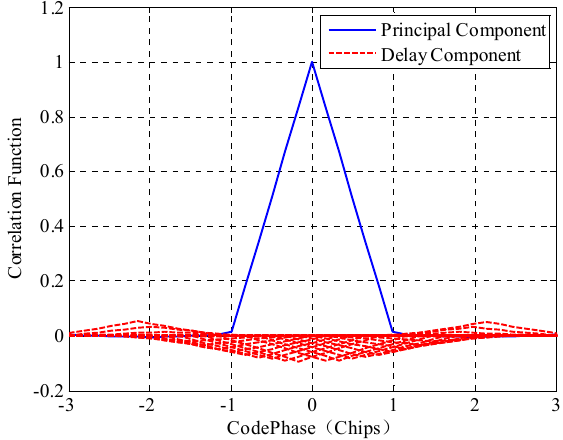
Figure 7. Correlation peak sidelobes formation diagram in traditional LMS algorithm.